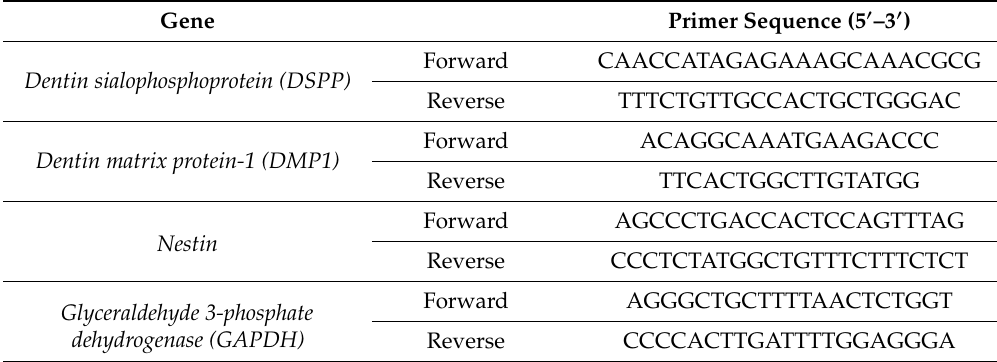
Table 1. List of primers for real-time